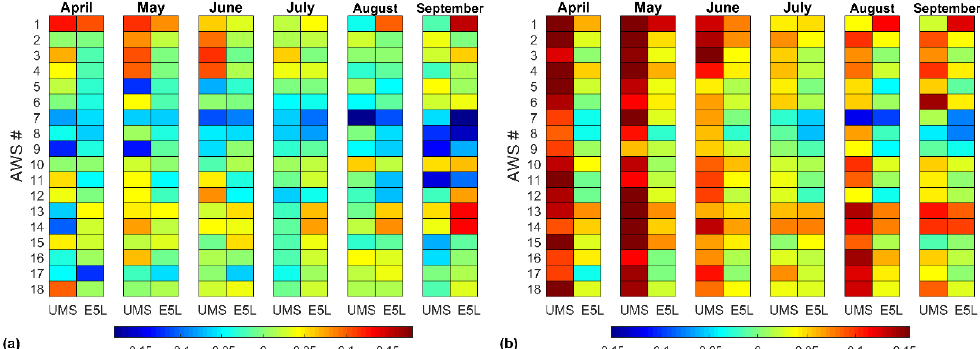
Figure 7. Differences between statistical indices of reanalysis data (UMS and E5L) and kriging (Figure 6): ( a ) absolute nBIAS; ( b ) nRMSE. Indices are normalized by the observed monthly mean value of ET 0 at the AWSs site of interest to allow comparison.